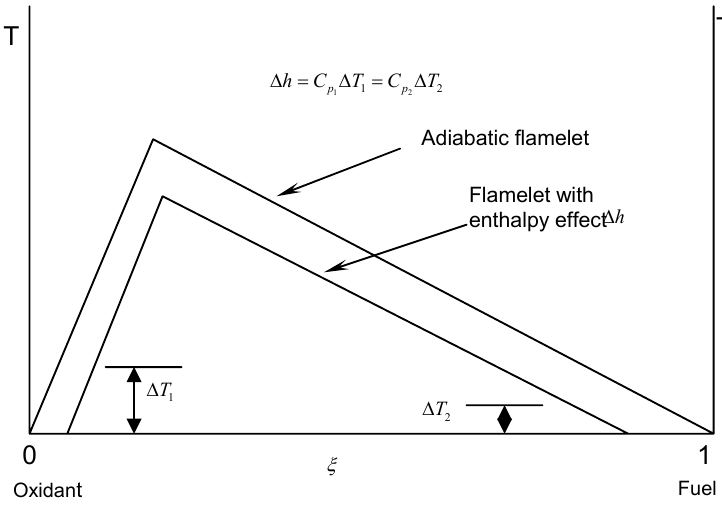
Figure 10. Modification of flamelet library for radiation